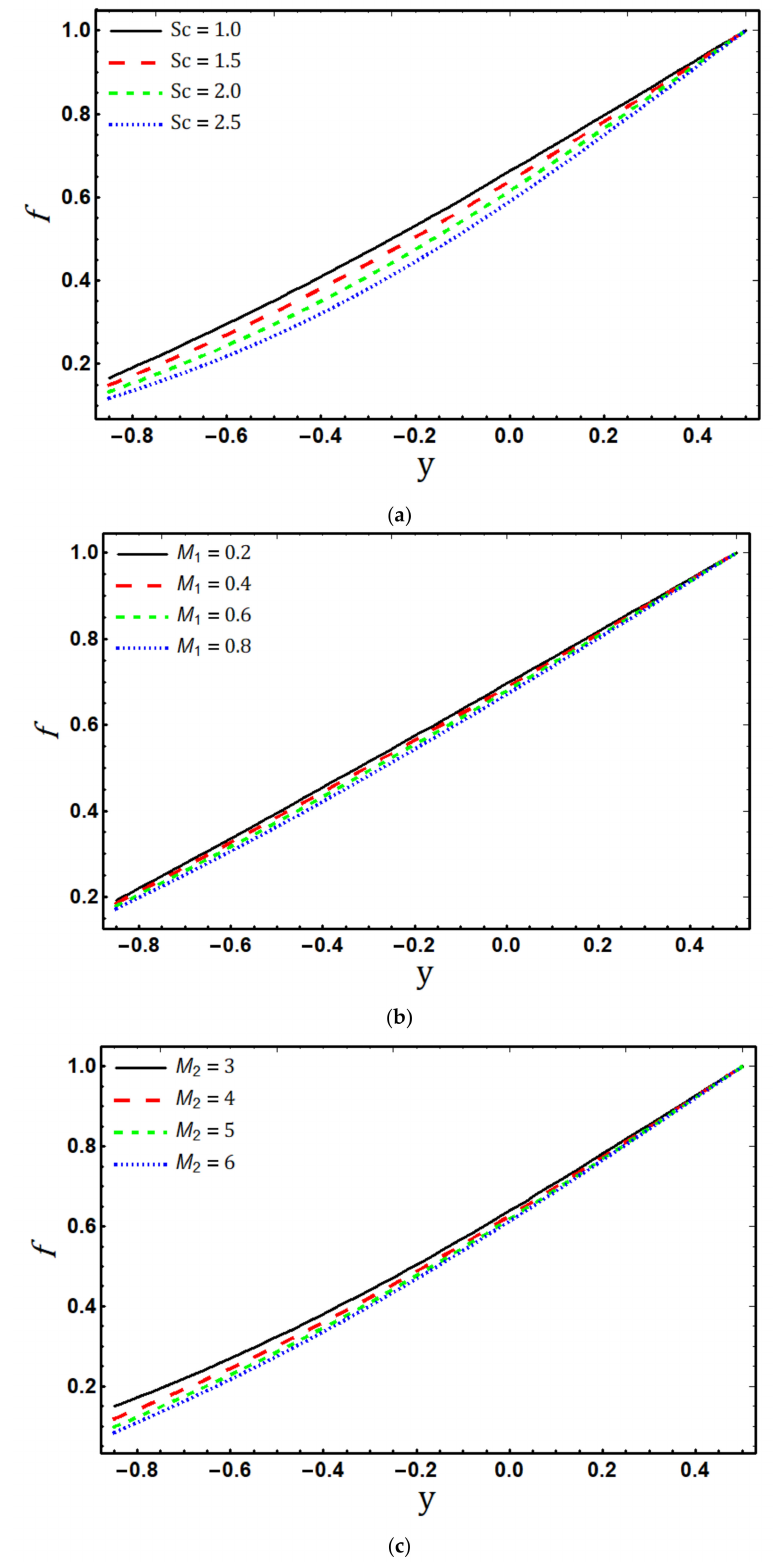
Figure 4. ( a ): Effects of Sc on f , while other parameters are b 1 = 0.3, b 2 = 0.5, x = 0.5, l = 1, ζ 1 = − 0.5, ζ 2 = − 0.4, U HS = − 0.5, Θ = 1.5, Φ = π /3, α = π /3, Ha = 1, B 1 = 0.3, M 1 = 3, G t = 0.6, m e = 1, G a = 0.8, B 2 = 0.02, M 2 = 1.5, γ = 0.6, Br = 0.5. ( b ): Effects of M 1 on f ,